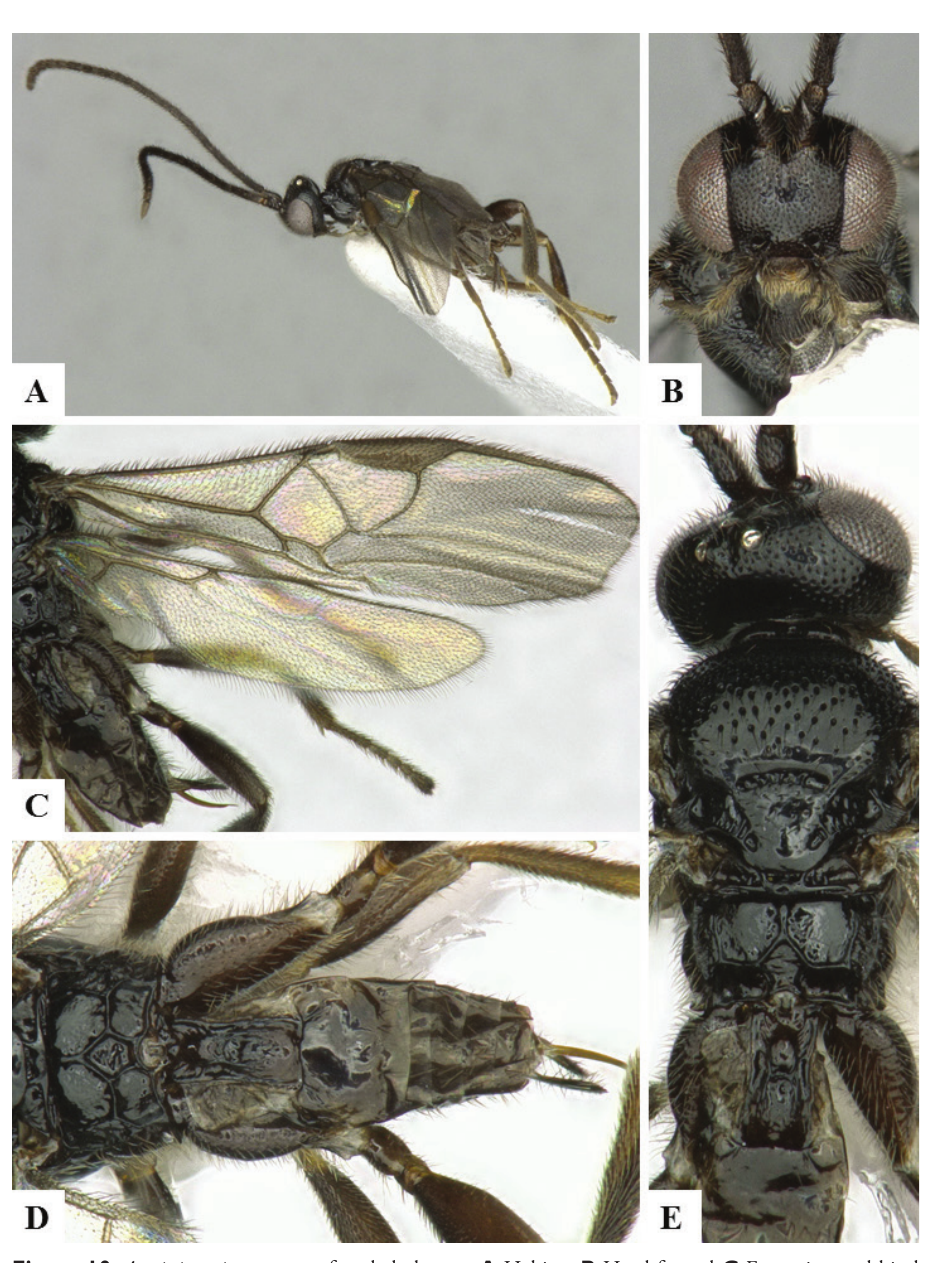
Figure 10. Austinicotesia papuanus female holotype. A Habitus B Head frontal C Fore wing and hind wing D Propodeum and metasoma, dorsal E Head and mesosoma ,